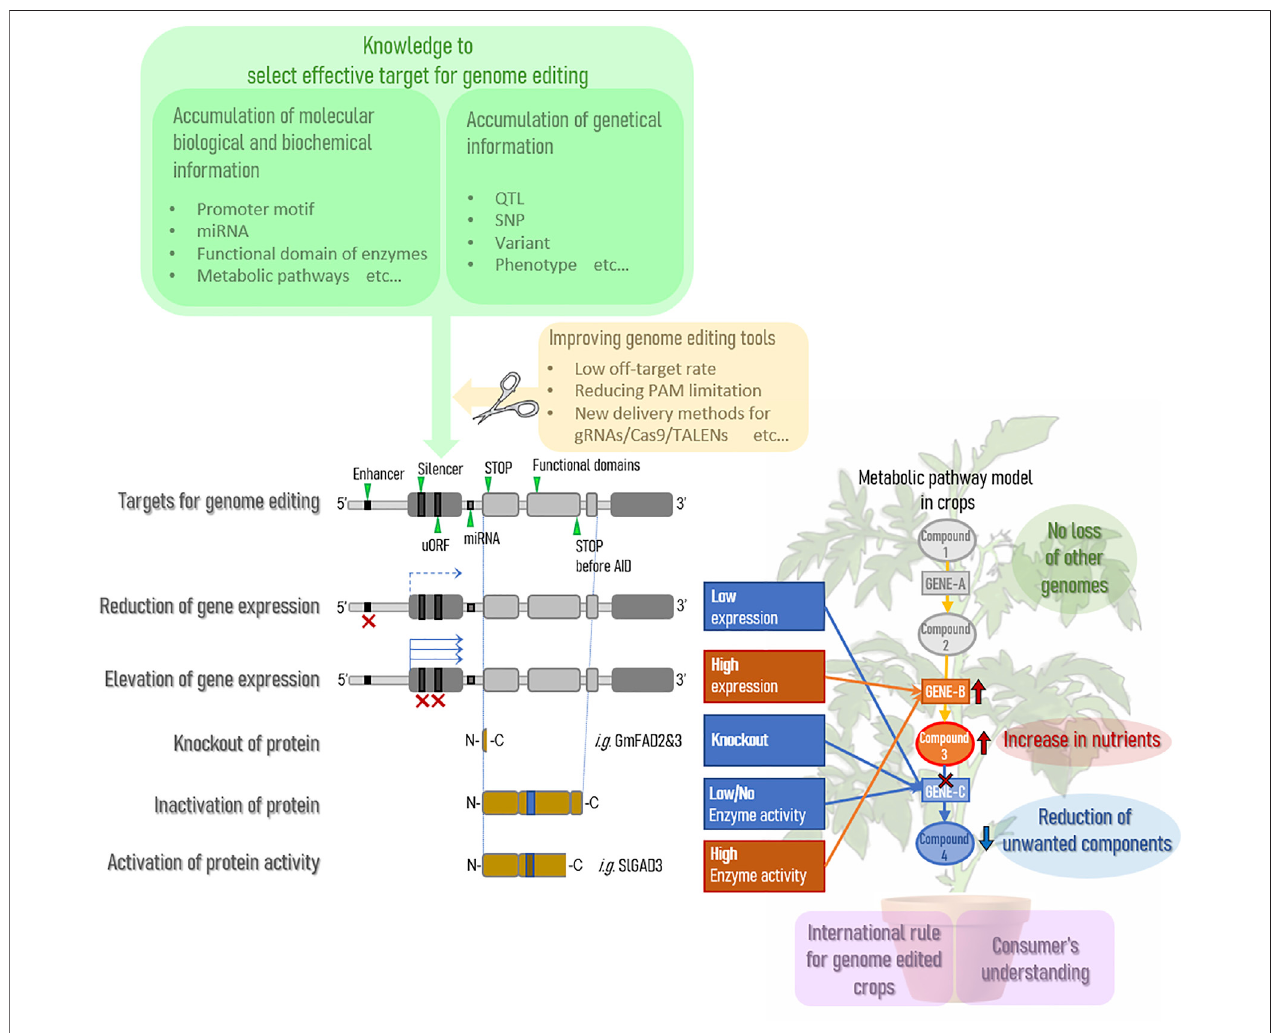
FIGURE 1 | Current situation on gene editing for enhanced nutrition in